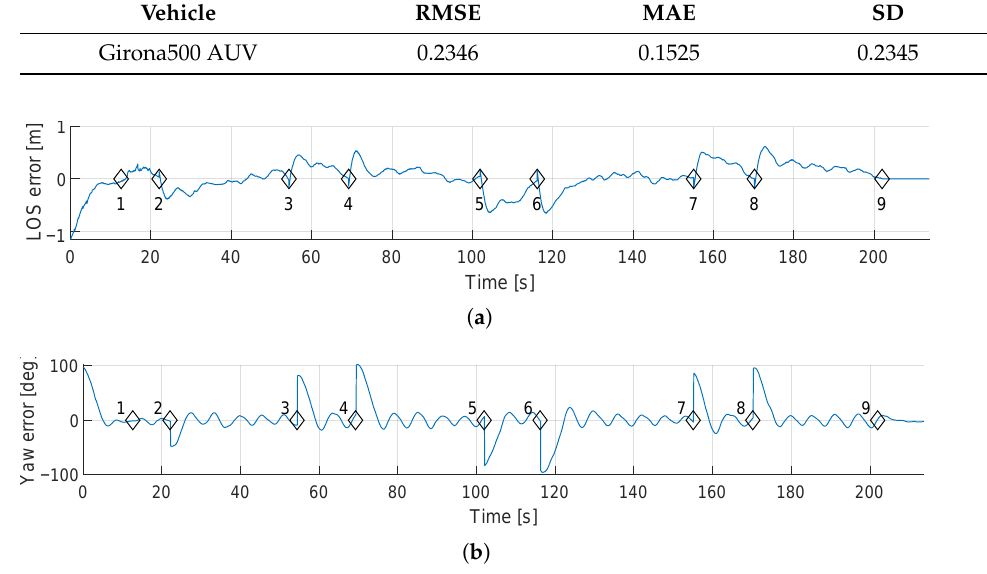
Figure 16. AUV errors at the LOS-based, path-following algorithm in Control scenario II, including the respective waypoints marked with their order number: ( a ) Cross-track error, ( b ) Yaw orienta- tion